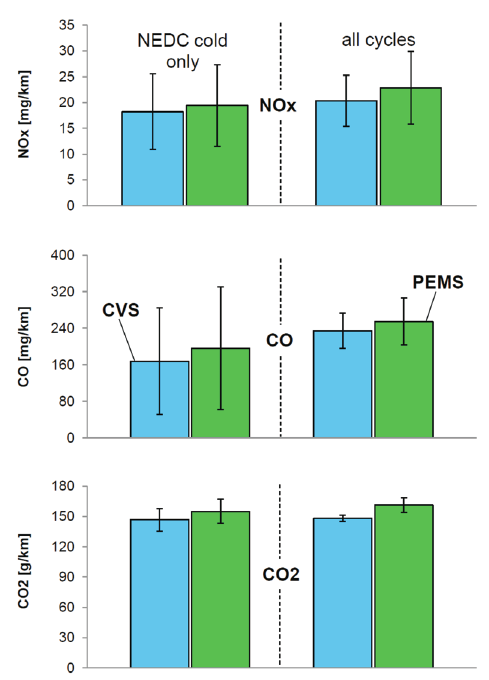
Fig. 7. Comparisons of average results: CVS versus all PEMS’s Each of the tested systems has some little and some big deviations. This conducts us to the statement that in the average view there is no best or worst system. All of them represent a similar balance of advantages and disadvantages and their measuring quality can be regarded as similar. There are of course still big potentials for improvements.